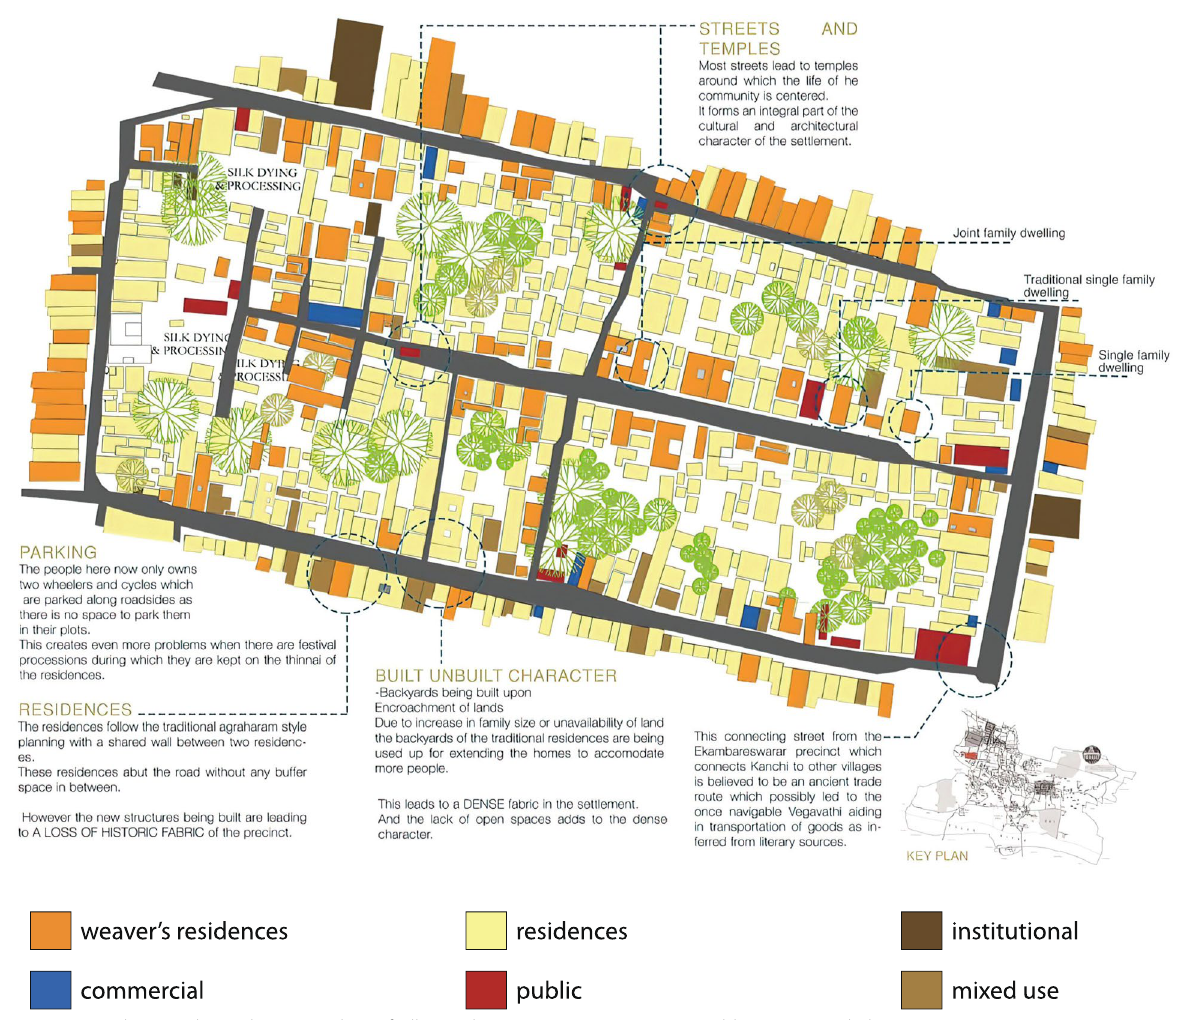
Fig. 4 Figure showing the settlement analysis of Pillayarpalayam weavers’ zone (Source: Abha Narain Lambah Associates